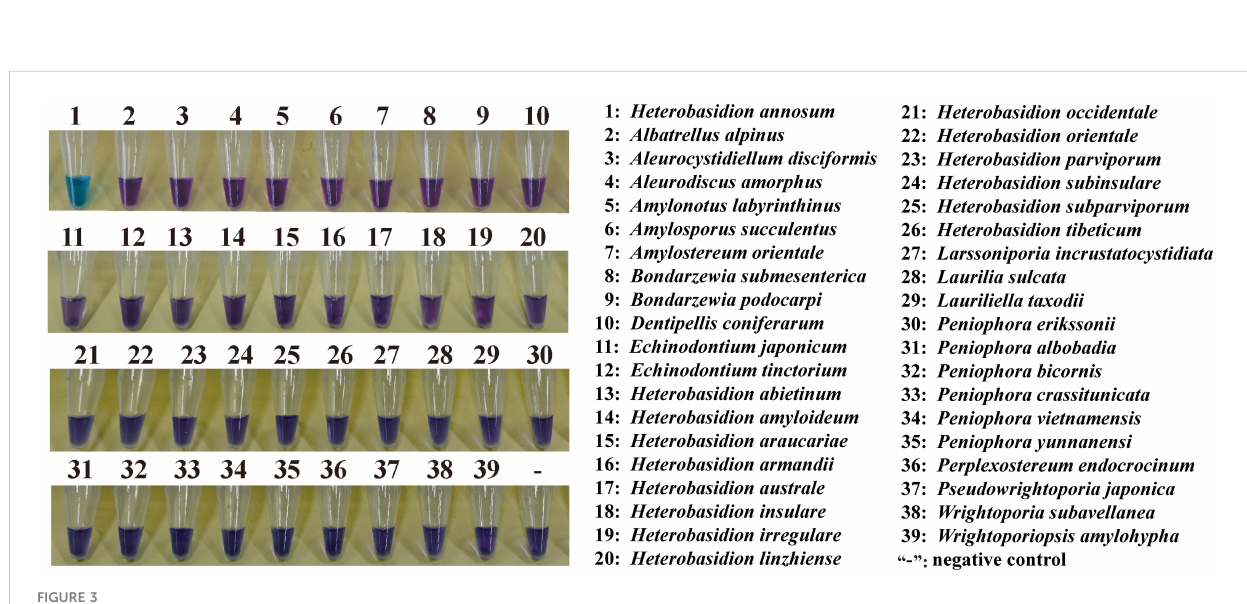
FIGURE 2 LAMP detection of the GAPDH gene in different isolates of Heterobasidion annosum . 1 – 7: H. annosum strains; “ - ” : negative control.